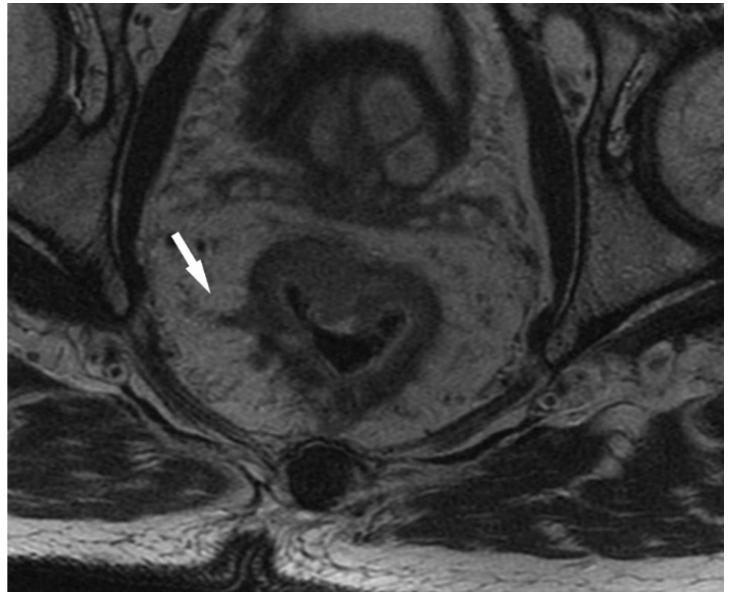
Figure 3. EMVI-positive rectal cancer. Axial T2-weighted MRI scan showing EMVI (white arrow).